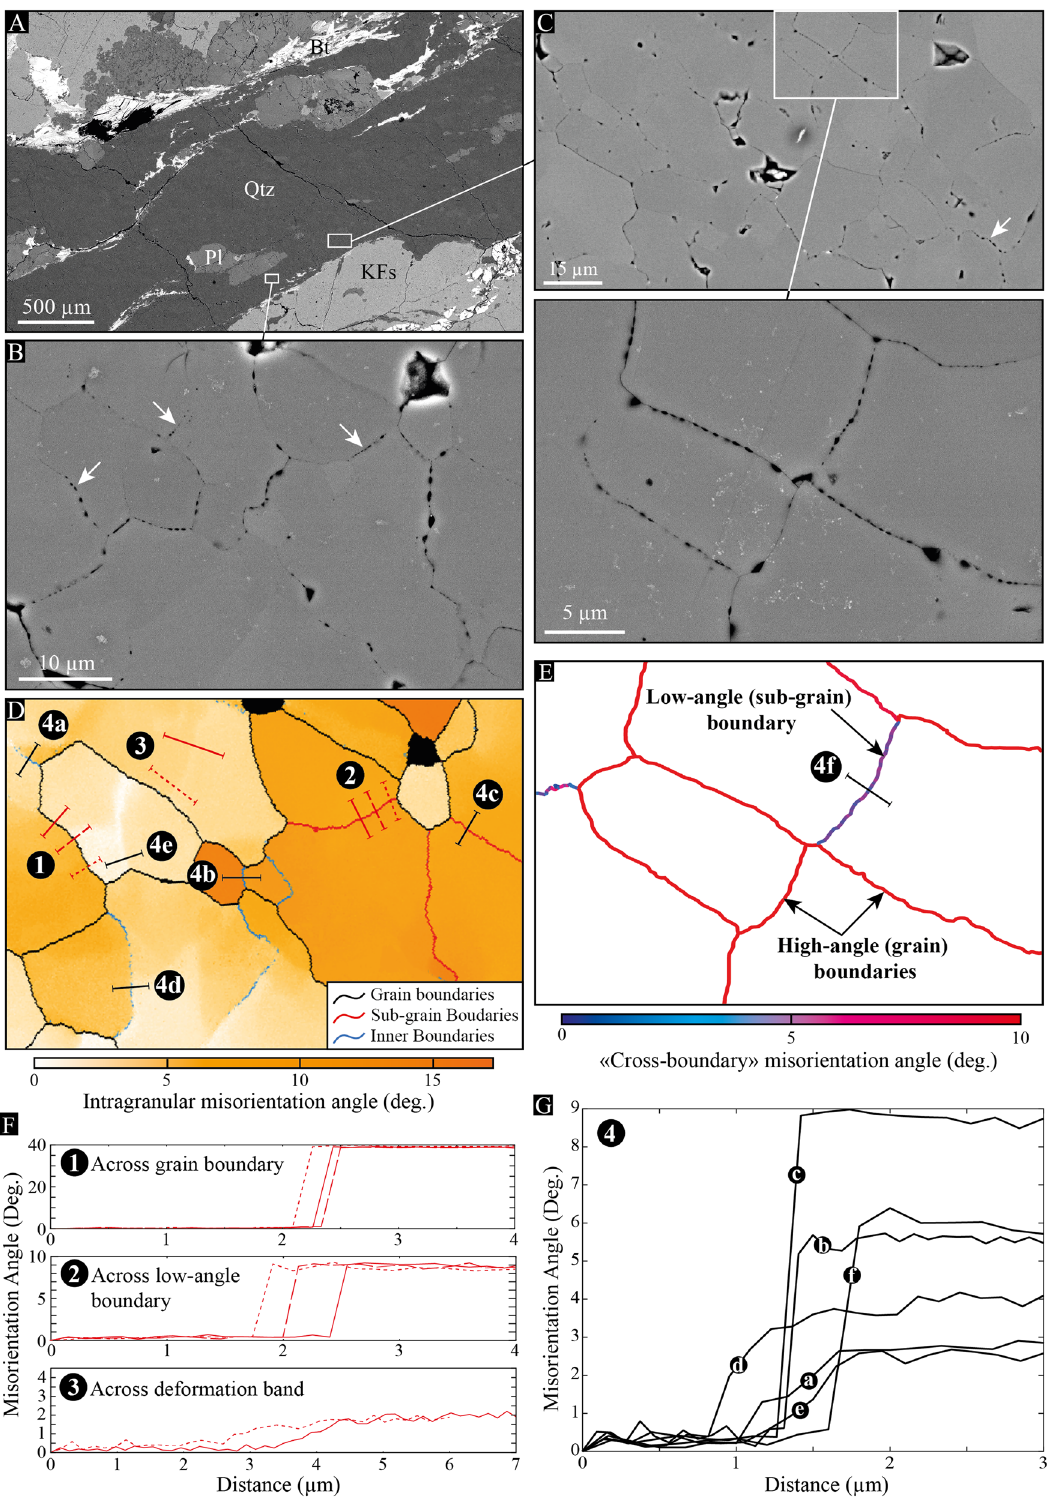
Figure 4. Micro-pores versus quartz boundaries. ( A–C ) BSE images of a quartz-rich shear band in grade 4, where the distribution and size of micro-pores have been compared to lattice misorientations using EBSD maps. White arrows indicate further examples of micro-pores, the size of which gradually increases (or decreases) along the boundary. ( D,E ) EBSD maps that documents intragranular misorientations (orange color bar) and “cross-boundary” misorientation angles (blue/red color bar) across the areas shown in ( B ) and ( C ), respectively. In ( D ), grain (misorientation angle > 10°), sub-grain and inner (misorientation angle between 2 and 10°) boundaries are respectively shown in black, red and blue. ( F ) Transects across three types of boundary: (1) grain boundary; (2) low-angle boundary; and (3) deformation band, all located in ( D ) using either solid or dashed lines. ( G ) Compilation of transects across low- angle boundaries and deformation bands located in ( D ) and ( E ). Although these boundaries describe misorientations ranging from 2° to almost 9°, all of them are decorated by micro-pores, regardless of the boundary